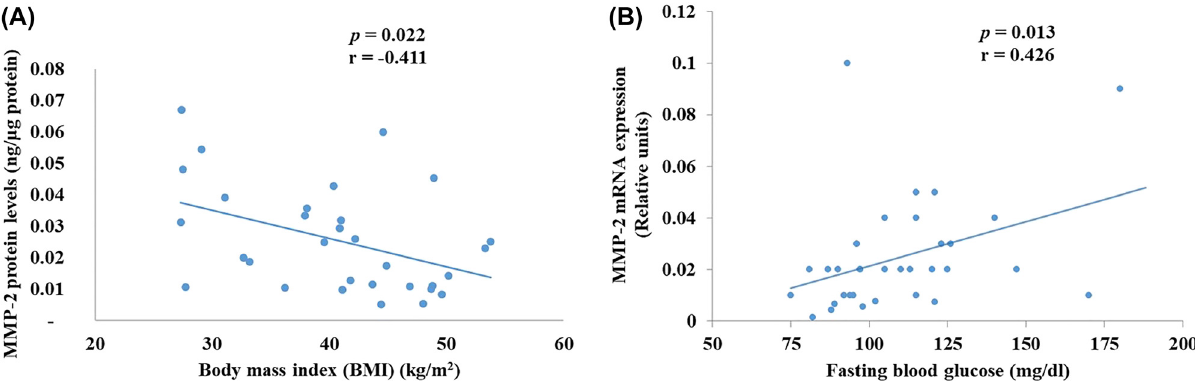
Figure2: CorrelationofadiposetissueMMP-2proteinlevelswithBMI(A)andMMP-2mRNAexpressionwithfastingbloodglucoselevels(B)in patients with obesity.